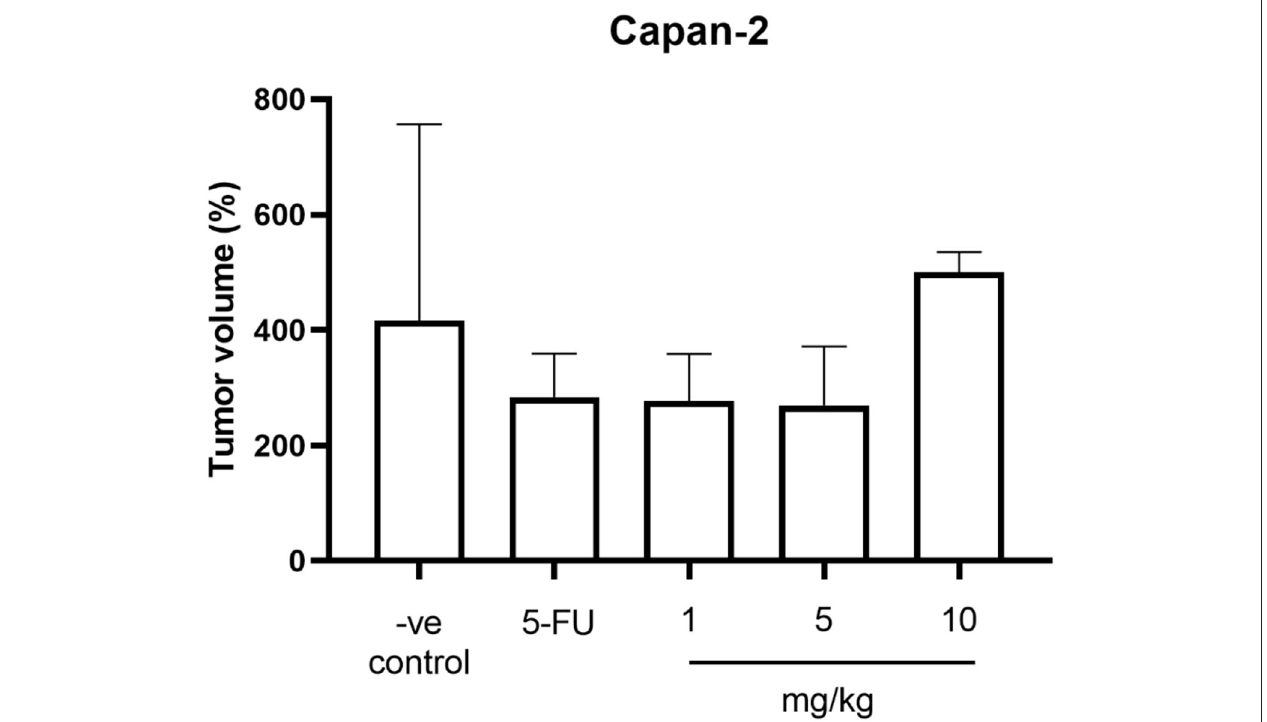
FIGURE 1 | The percentage of tumor volume changes of mice in the negative control group, the positive control group (5-FU), and THC:CBD at dose of 1, 5, and 10 mg/kg BW.